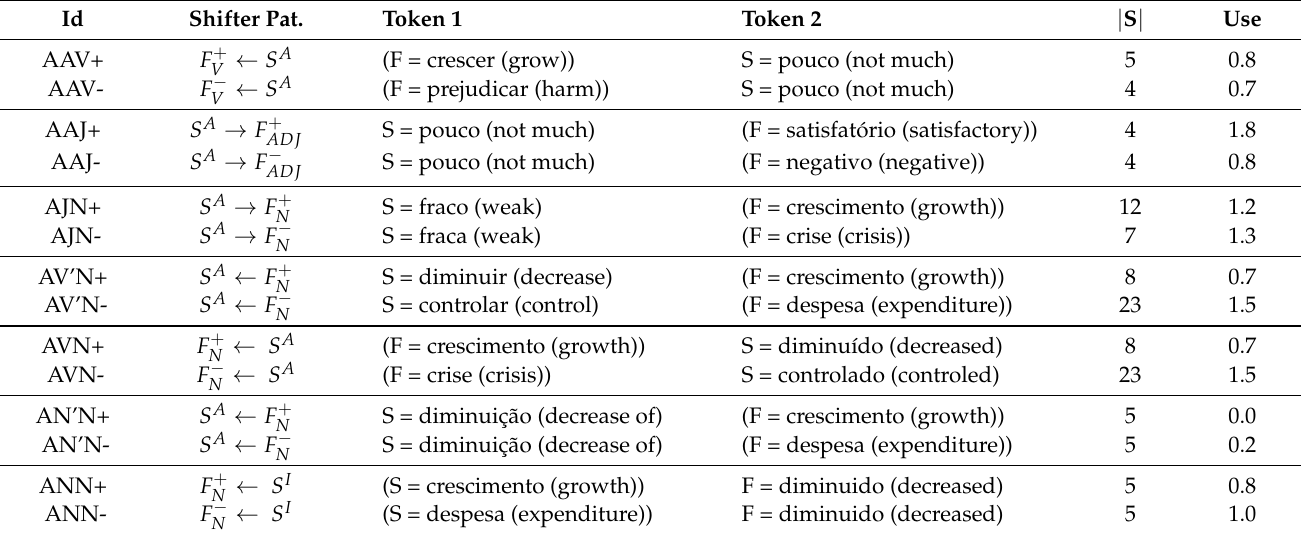
Table 6. Some shifter patterns that include